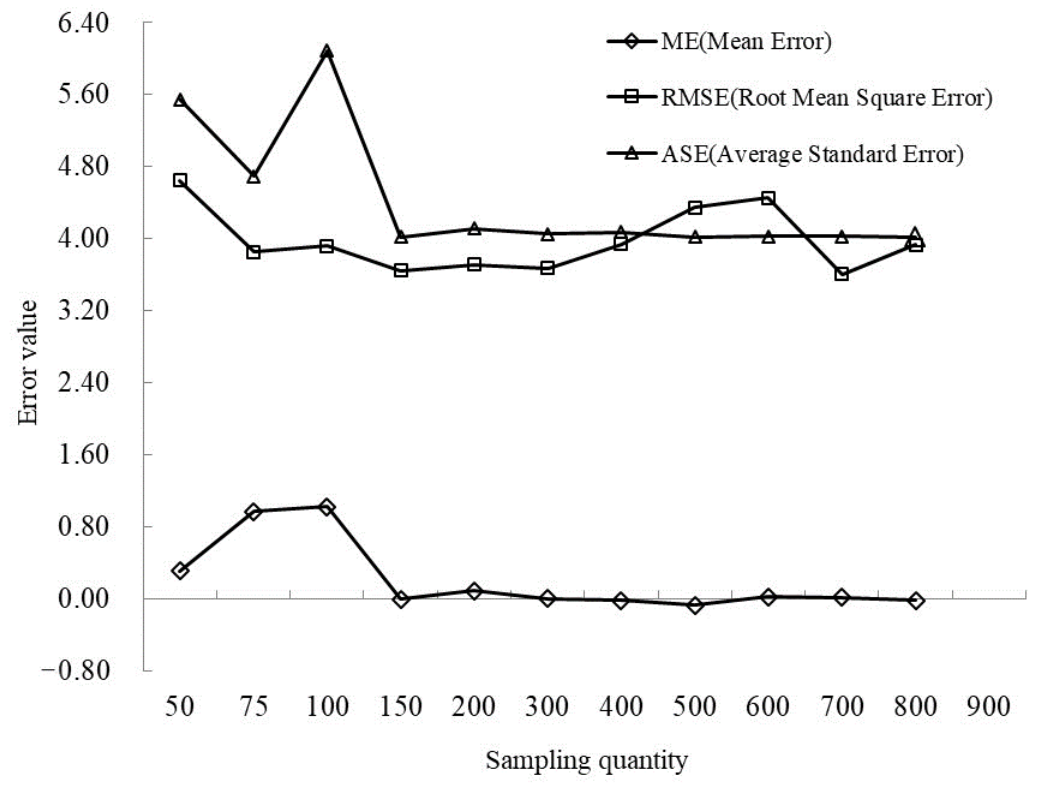
Figure 3. The spatial prediction error of SOM in different number of sampling points.